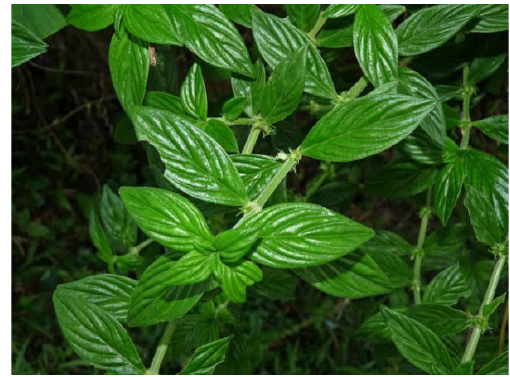
Fig. 1. An aerial part of D. sarmentosa